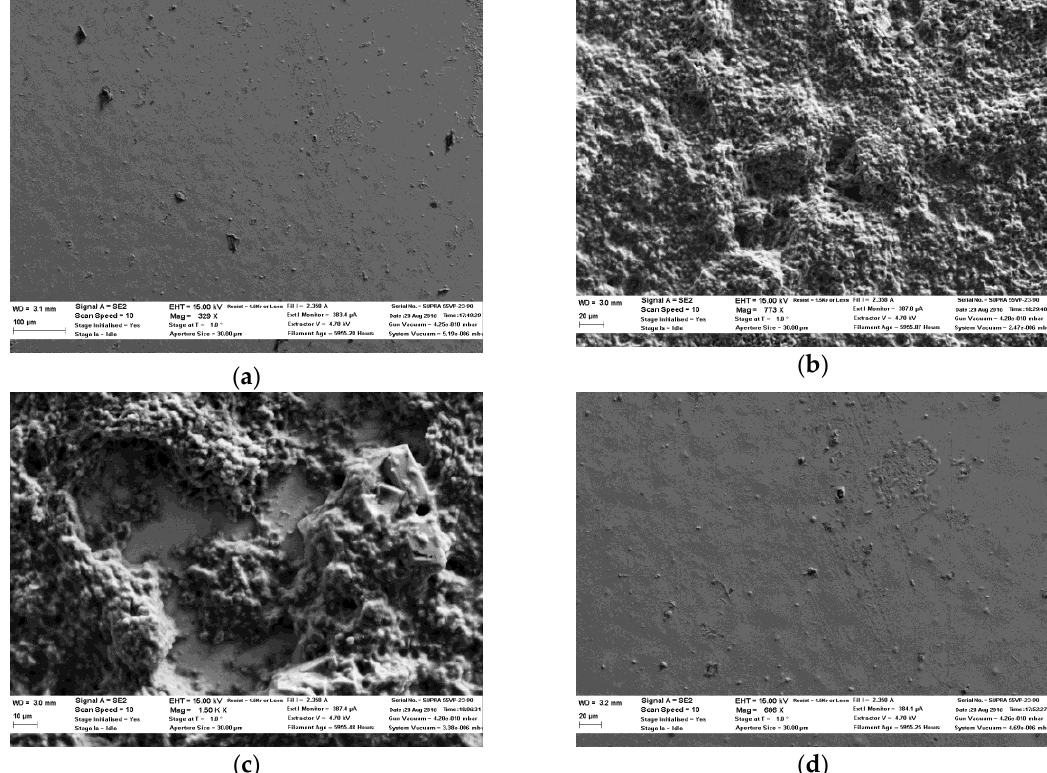
Figure 12. ( a ) SEM photos of IrO x film before loaded with enzymes. ( b ) SEM photo showing the structure of the cured lactate protein on the IrO x surface. ( c ) SEM photo of the IrO x sensor after being used for three weeks. The opening area in the center shows the missing enzyme protein. ( d ) SEM photo of the IrO x surface after the probe was used for a month.